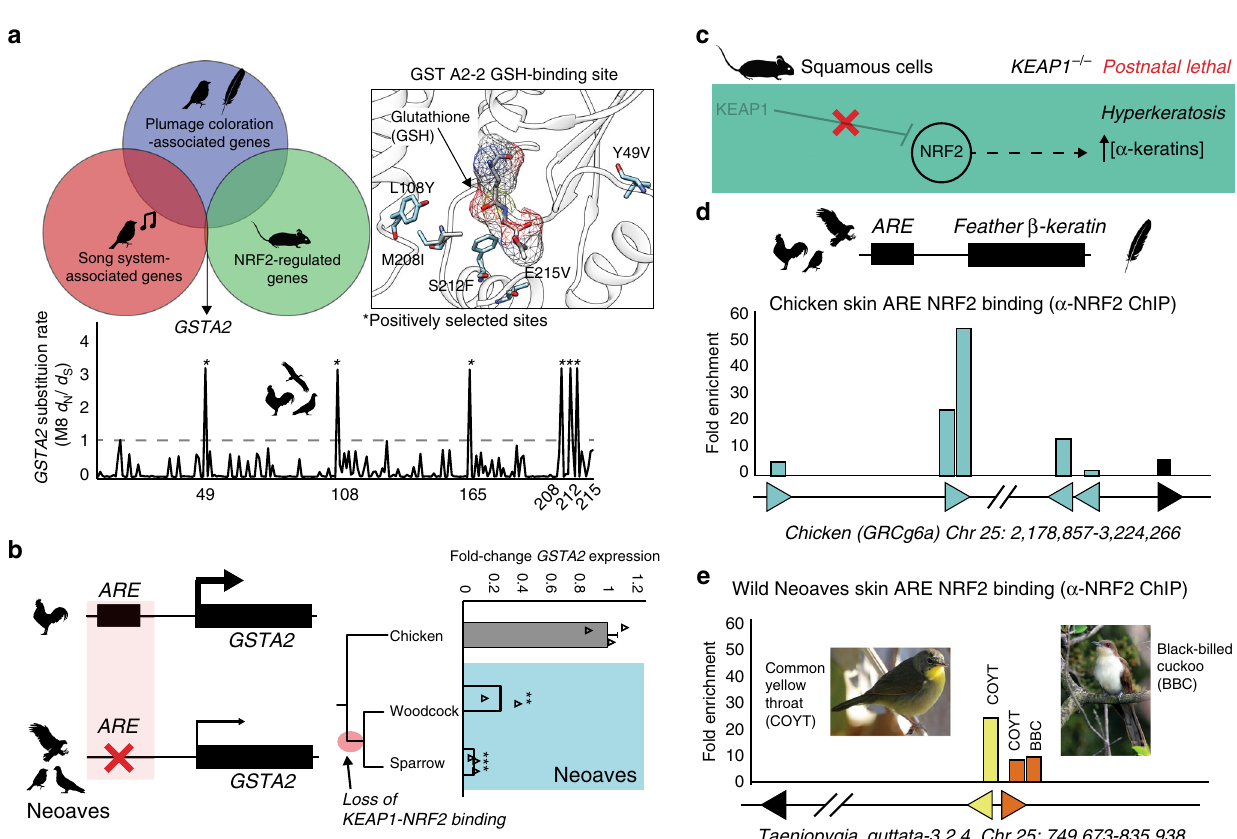
Fig. 4 Evolutionary trade-offs of constitutive NRF2 activity in feather development genes. a Glutathione S -transferase A2 (GSTA2) is shared among gene sets associated with: (1) NRF2-regulation in mice; (2) plumage coloration in Neoaves; and (3) the Zebra fi nch song system 32, 36,37 . Avian GSTA2 is a target of positive selection ( p < 10 − 17 ; M8 PAML, Supplementary Table 9). GSTA2 sites targeted by natural selection ( d N / d S = 3.50) are located within the glutathione (GSH)-binding site (PDB ID: 2WJU) and display Neoaves-speci fi c amino acid variants. b Loss of an NRF2 antioxidant response regulatory element (ARE) in Neoaves (Woodcock, N = 2 biologically independent animals; Sparrow, N = 3 biologically independent animals; Supplementary Table 8) is consistent with a signi fi cant decrease in GSTA2 expression relative to that of Chicken [ N = 3 biologically independent animals]. ** p = 0.005, *** p = 0.0012, respectively, one-sided t test. Data are presented as mean values. c KEAP1 knockout mice die from starvation shortly after birth from hyperkeratosis of the gastrointestinal tract, likely through overexpression of α -keratins and loricrins in squamous cells 38 . d AREs were detected upstream of β -keratins across avian genomes (Supplementary Table 7). Skin chromatin immunoprecipitation (ChIP) with anti-NRF2 antibody revealed NRF2 occupancy of AREs for feather β -keratins (grey) and loricrin (black) identi fi ed within the Chicken genome. e AREs for feather β -keratins are markedly deceased in the Zebra fi nch genome (Supplementary Table 7) and display a trend toward decreased NRF2 occupancy in ChIP analysis of the skin obtained from two highly diverged wild Neoaves species (common yellow throat Geothlypis trichas and Black-billed cuckoo Coccyzus erythropthalmus ). “ Female Common Yellowthroat ” (CC BY-SA 4.0) Sandhillcrane https://commons.wikimedia.org/wiki/File:Female_Common_Yellowthroat.jpg, no changes were made. “ Black-Billed Cuckoo ” (C) 2008 Wolfgang Wander (GFDL). Source data are provided as a Source data fi le. All error bars represent standard